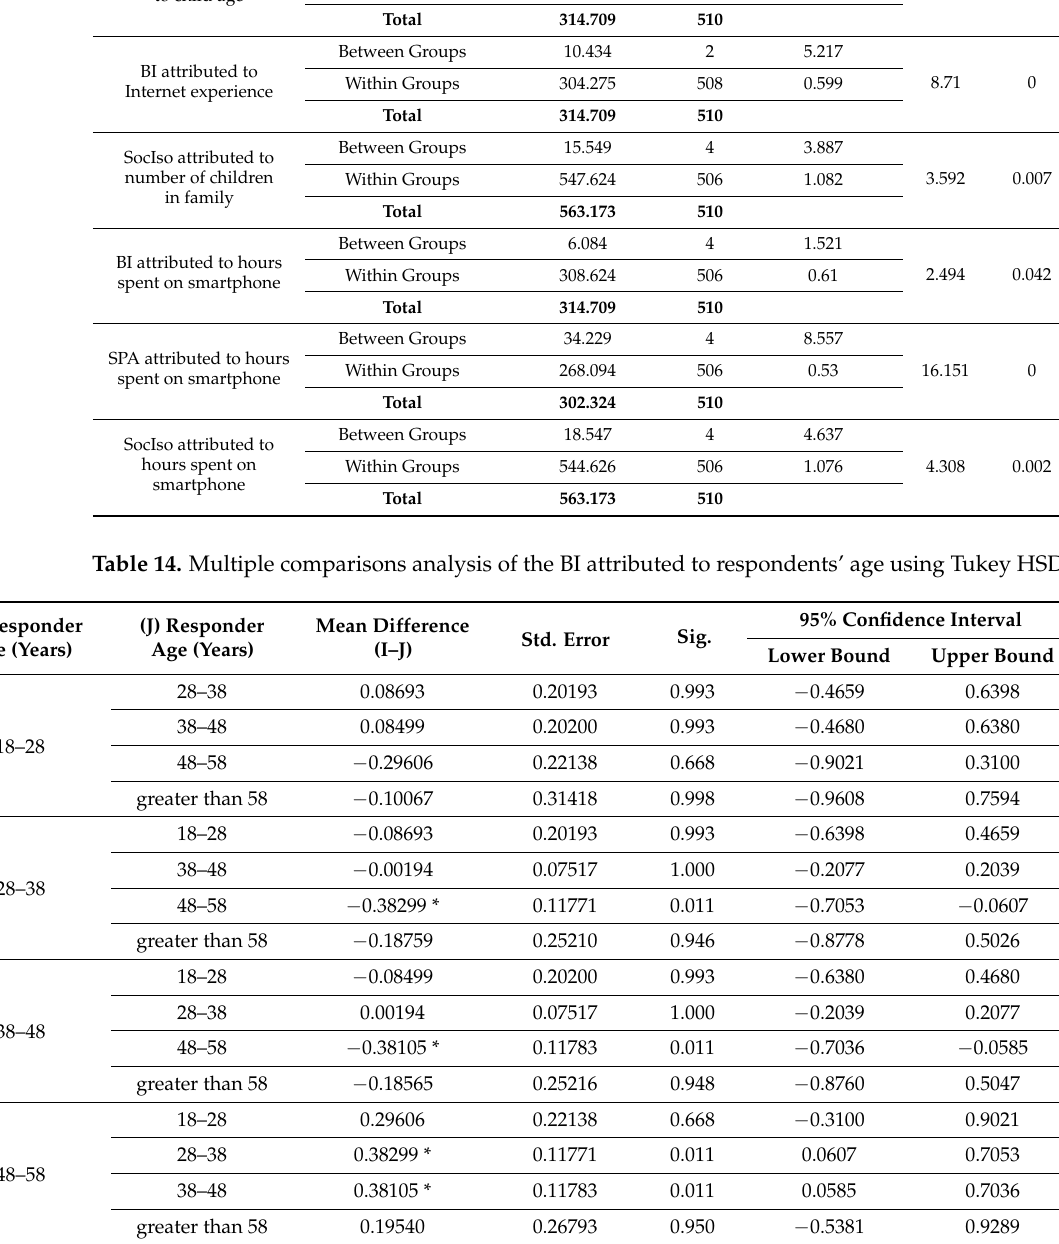
Table 13. ANOVA analysis of respondents’ BI, SocIso, and SPA attributed to respondents’ age, child age, internet experience, number of children in the family, and time spent using a smartphone. Sum of Squares df Mean Square F Sig. Between Groups BI attributed to respondents age